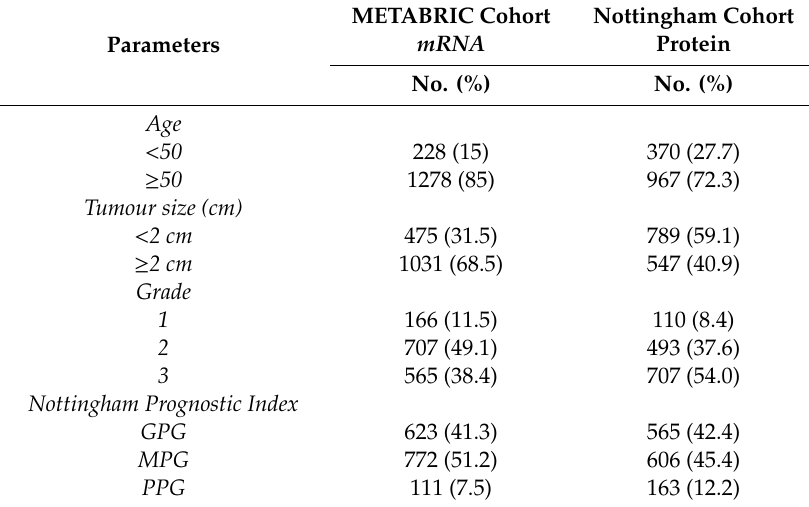
Table 5. Clinicopathological characteristics of ER +/ HER2 − breast cancer